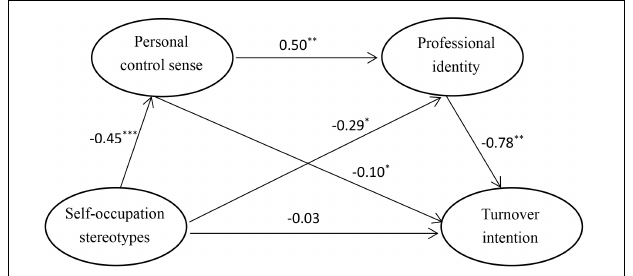
FIGURE 1 | Multiple mediating roles of personal control sense and professional identity in the relationship between self-occupation stereotypes of private kindergarten teachers and turnover intention. Standard path coefficients were presented. ∗ p < 0.05, ∗∗ p < 0.01, ∗∗∗ p < 0.001. N = 688.